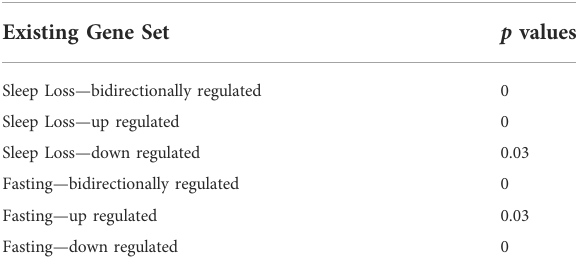
TABLE 4 Potential in fl uence of sleep loss and fasting in IC group: Previous studies (Cedernaes et al., 2018; Defour et al., 2020) identi fi ed genes differentially expressed in human adipose tissue following sleep loss or